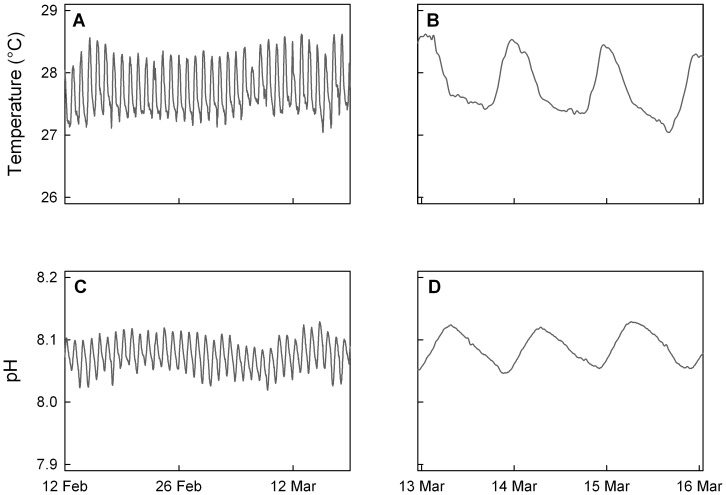
Time series of temperature and pH at a fringing reef in Moorea, French Polynesia.During the month prior to larval release, environmental temperature (A) and pH (C) oscillated on a 24-hour period. A three-day window, March 13–15, 2011, corresponds to ambient temperature (B) and pH (D) conditions adjacent to the natal reef of the larvae used in manipulative experiments on those days. Temperatures represent averages from duplicate thermisters, processed by a one-hour low-pass filter. pH data from a SeaFET sensor were processed by a one-hour low-pass filter.